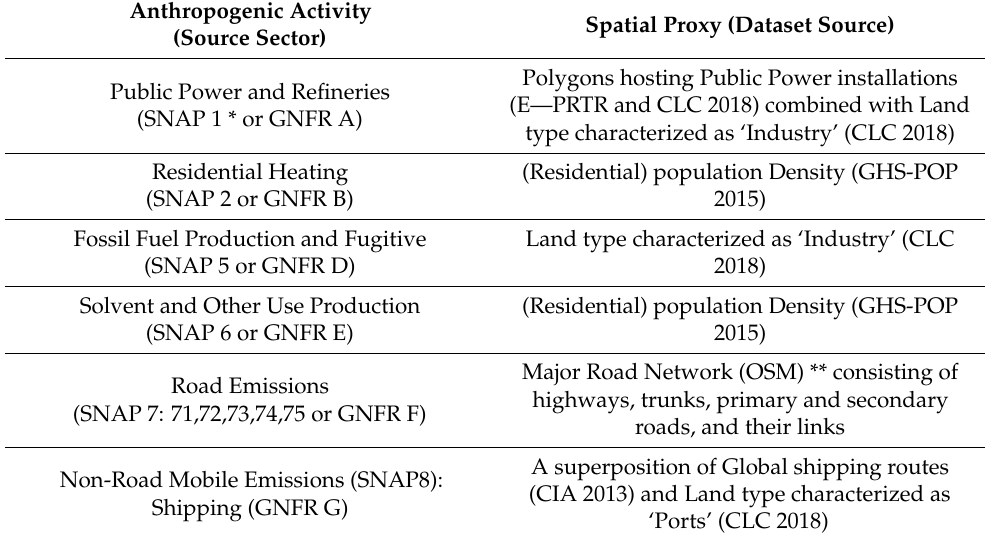
Table 1. The spatial proxies (and their origin) used to disaggregate each anthropogenic activity (expressed as source sectors in SNAP and GNFR) in the proposed downscaling framework. More information on all spatial datasets used can be found in Appendix A.